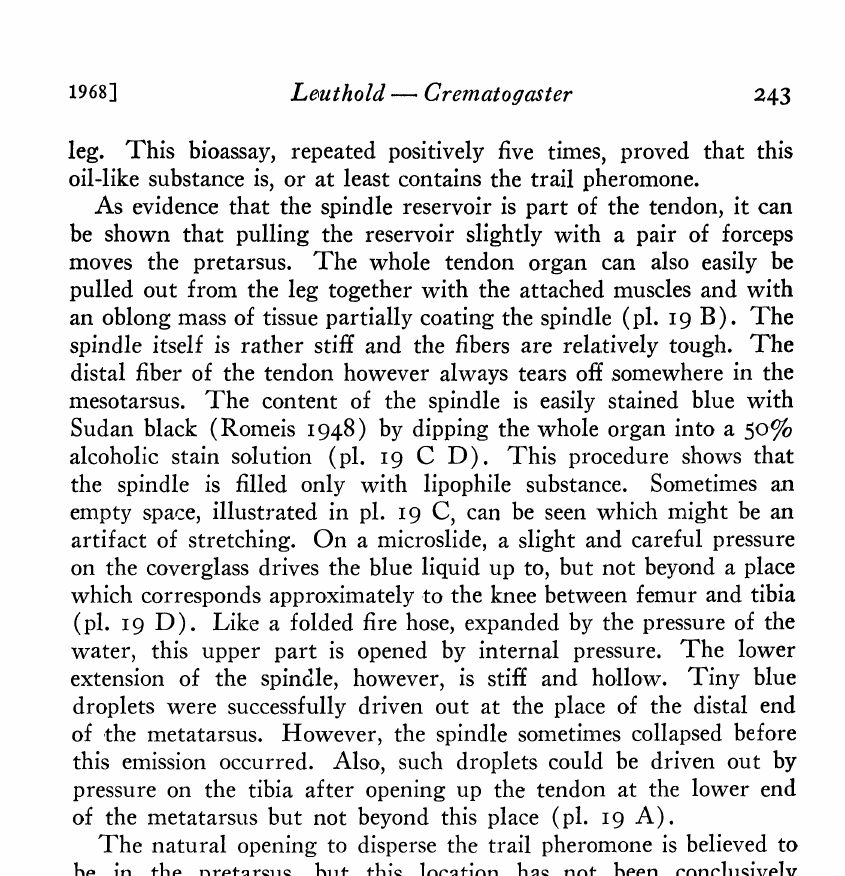
Fig. 4. (opposite page) Slow motion sequences (64 trames per second) ot trail-laying ants. A. Hindlegs trom lateral view B. Foot movements trom lateral view C. Moderately active trail-laying trom dorsal view (short black lines indicate positions on the legs in contact with